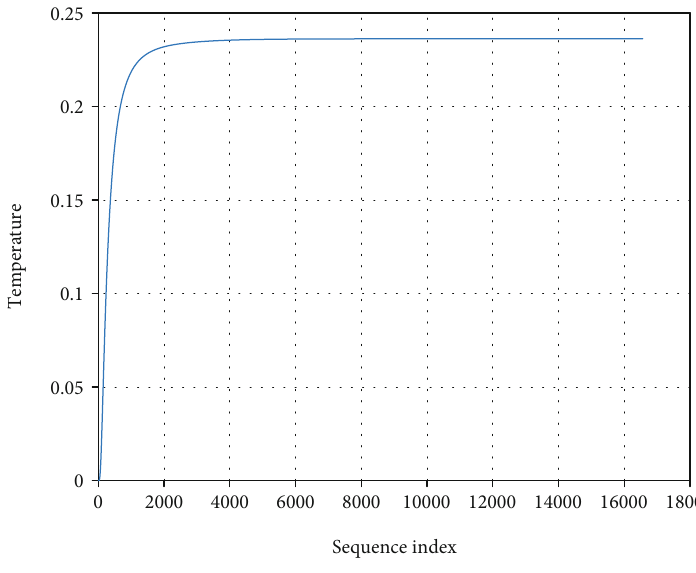
Figure 5: Sequence behavior at point 0.25.